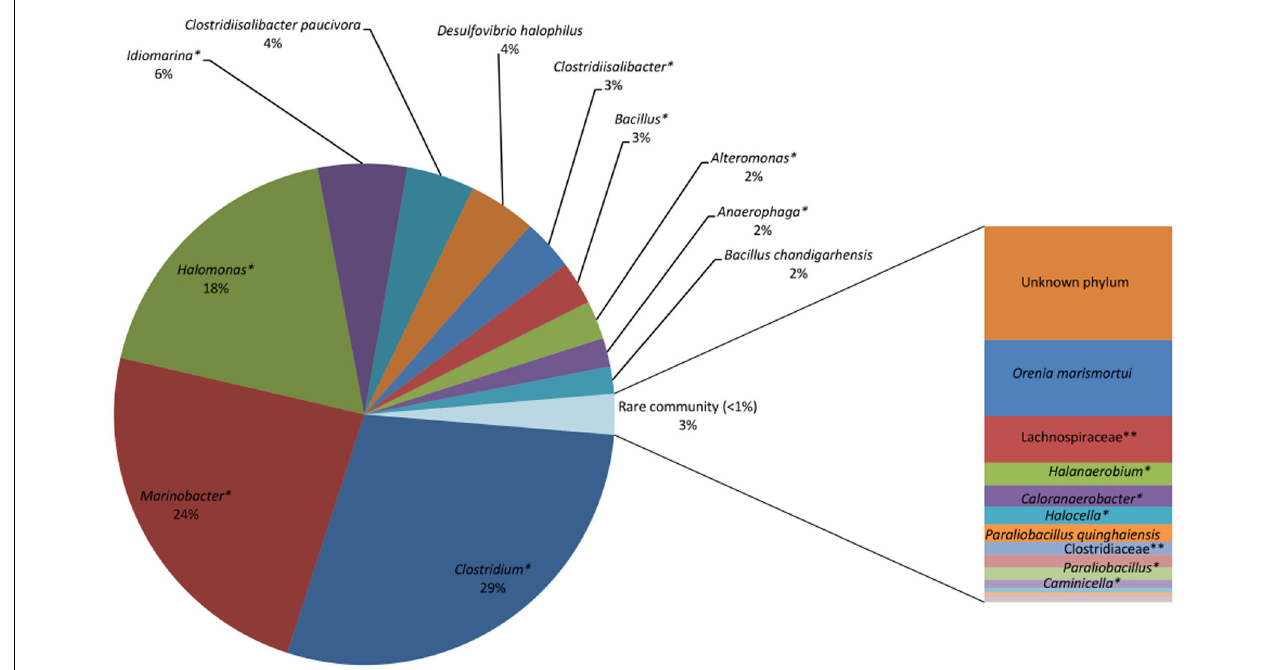
Clostridiisalibacter (3%), Bacillus (3%), and Alteromonas (2%). Known species identified include Clostridiisalibacterpaucivora (4%), Desulfovibrio halophiles (4%) and Bacillus chandigarhensis (2%). ∗ Unknown species